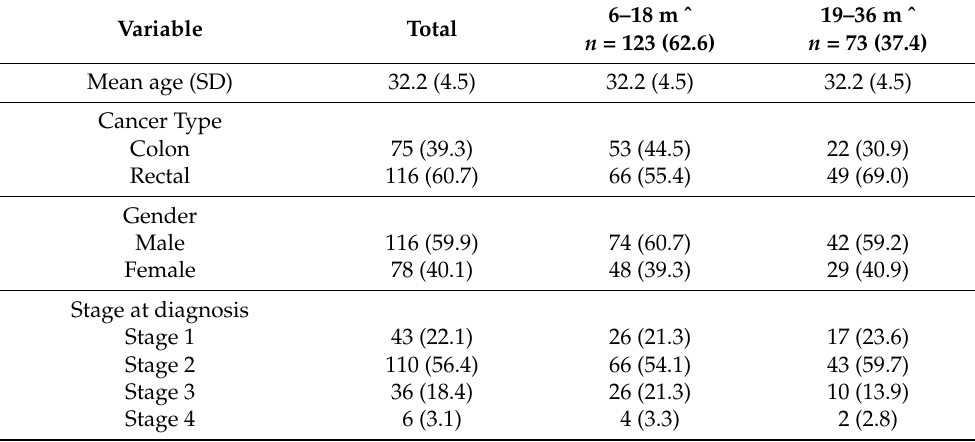
Figure 1. Recruitment and inclusion flow chart. Table 1. Characteristic of the overall sample and by time from diagnosis ( n = 196).